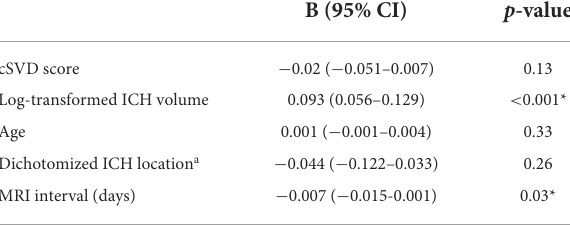
TABLE 2 Multivariable linear regression model investigating predictors of